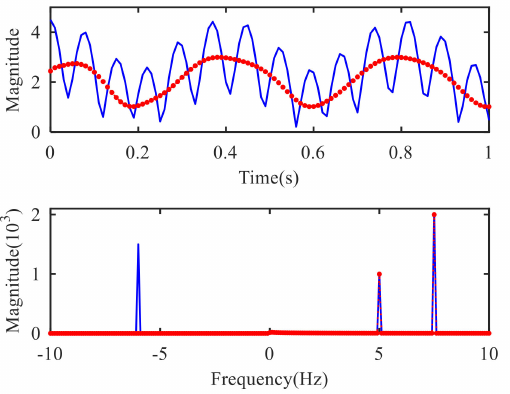
Figure 1. Original signal (blue solid line) and reconstruction signal by VMD (red dashed